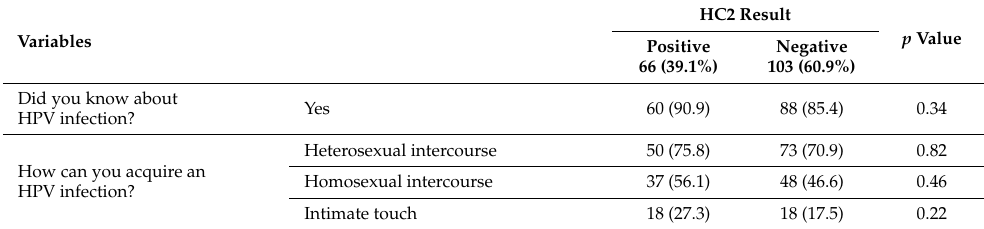
Table 3. HC2 results in correlation with knowledge about